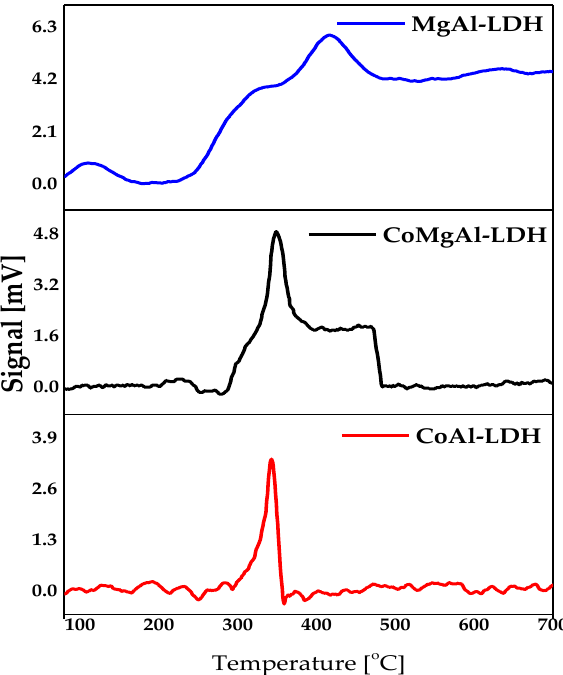
Figure 6. CO 2 -TPD profile for all the investigated solid materials.